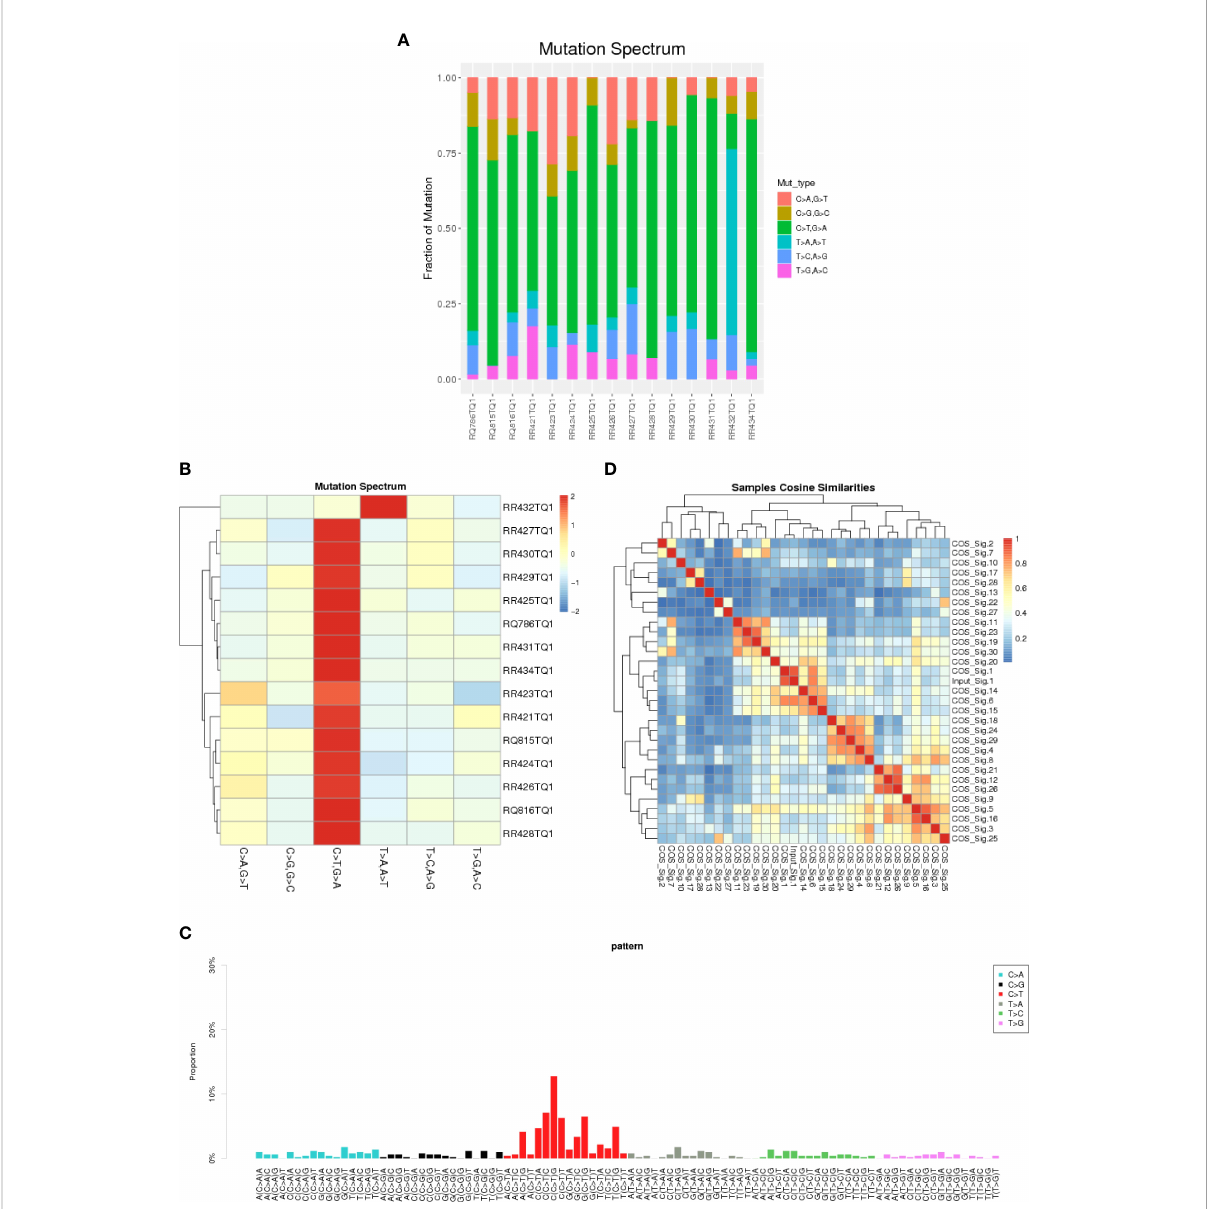
FIGURE 1 A barplot (A) and heatmap (B) depicting the mutation spectrum of the GI-NKTCL cohort. (C) The mutation pattern of the GI-NKTCL cohort obtained via Nonnegative Matrix Factorization (NMF). (D) Heatmap showing the correlation between the COSMIC